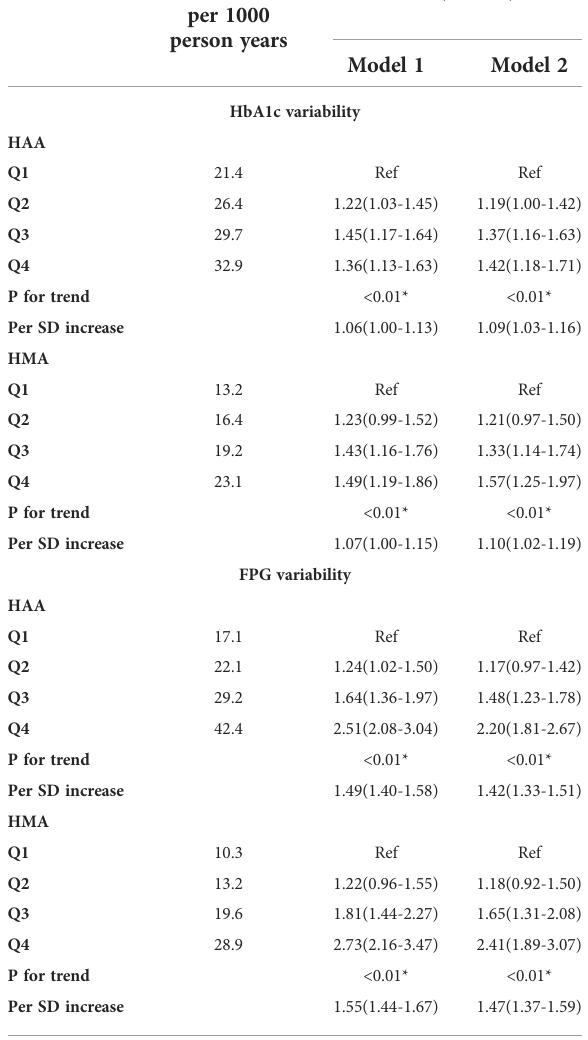
TABLE 2 Association between HbA1c/FPG variability and prede fi ned